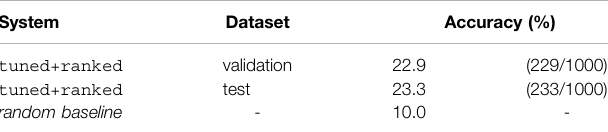
TABLE 7 | Accuracy of the tuned+ranked model at predicting the story continuationthatwasselectedbytheMechanical Turkerwhoconstructed the